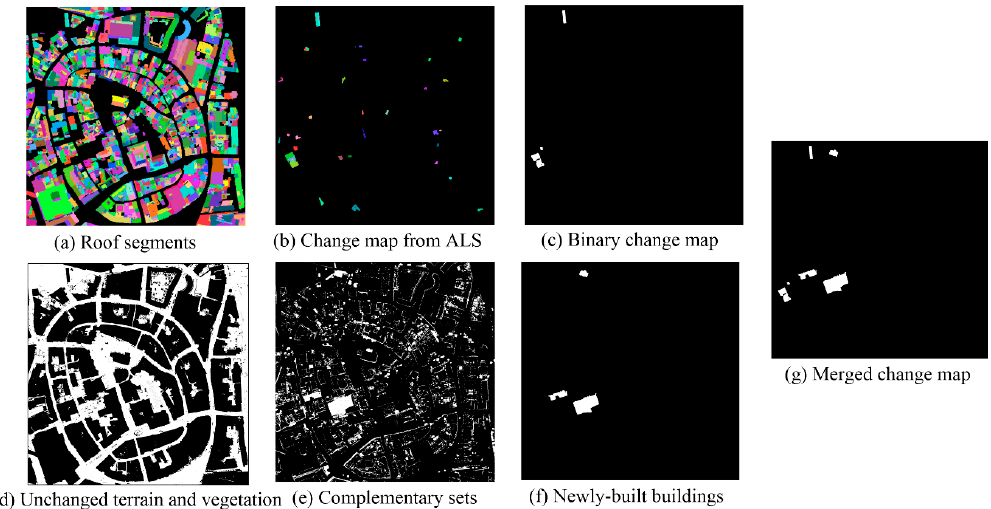
Figure 11. Intermediate products of the method for Enschede data.